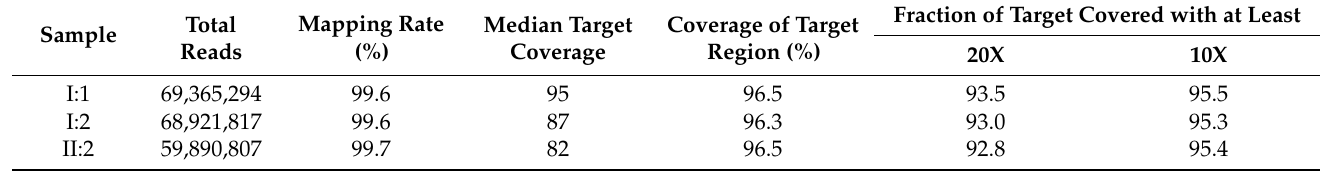
Figure 2. ( a ) A panoramic radiograph of the proband taken at age 9 years 9 months. The first per- manent and deciduous molars have been treated by stainless steel crown restoration. Severe hypo- and premolars can be observed (asterisks). The first permanent molars exhibit taurodontism (white arrow heads). ( b ) A panoramic radiograph of the proband taken at age 13 years 9 months. Erupted canines and premolars show a blunt root apex with enlarged pulp chambers (asterisks). Table 1. Statistics for whole exome